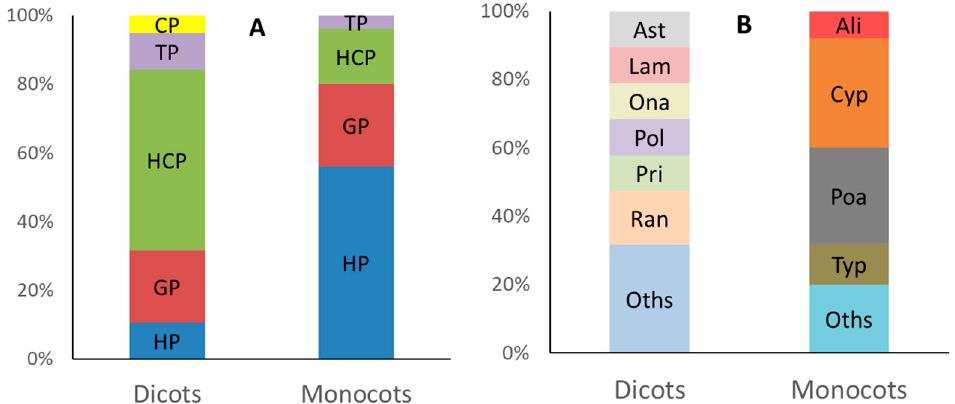
Figure 1. Ratios of life forms ( A ) (HP, helophyte; GP, geophyte; HCP, hemicryptophyte; TP, thero- phyte; CP, chamaephyte) and families ( B ) (Dicots: Ast, Asteraceae ; Lam, Lamiaceae ; Ona, Onagraceae ; Pol, Polygonaceae ; Pri, Primulaceae ; Ran, Ranunculaceae ; Oths, all other families in which only